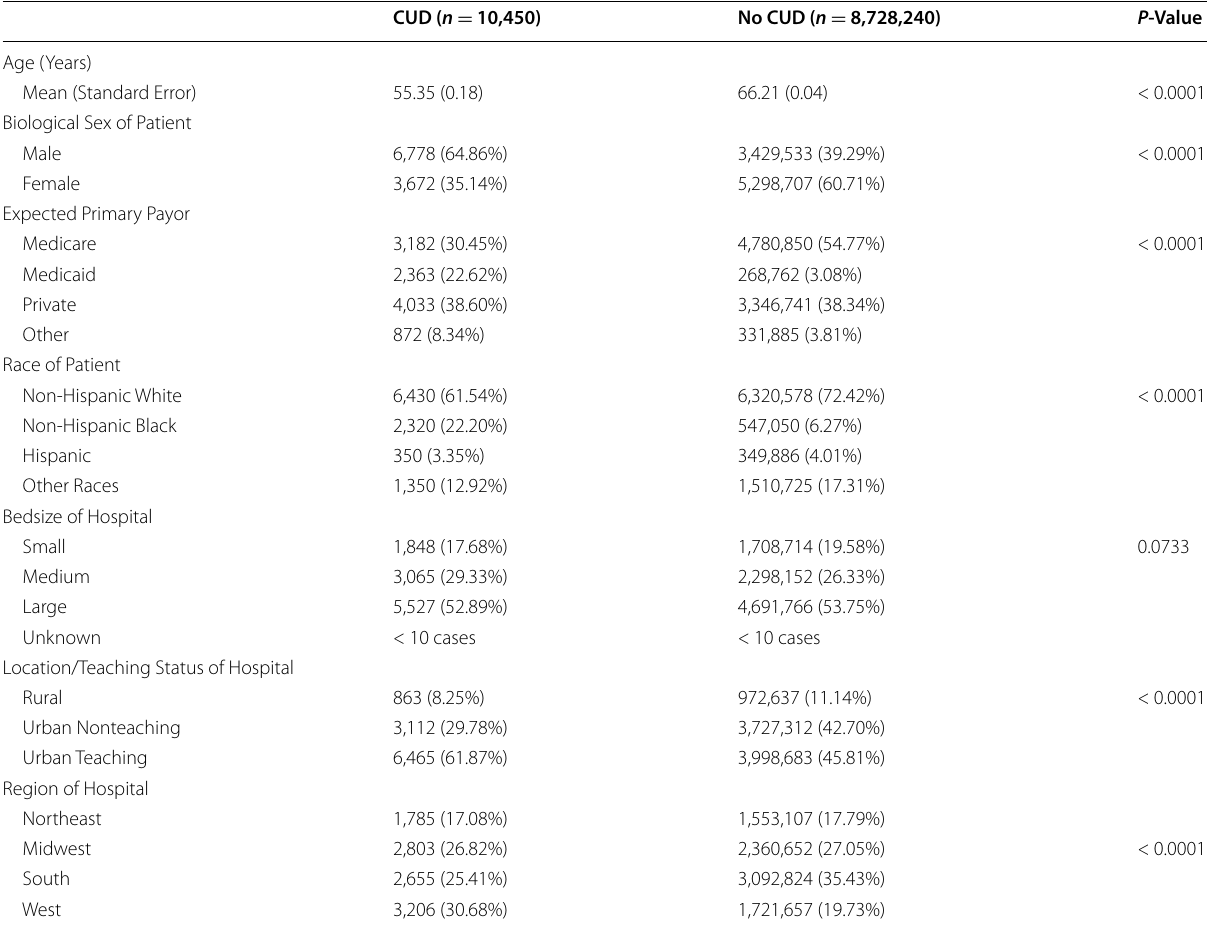
Table 2 Demographic and hospital factors, stratified by CUD vs . no